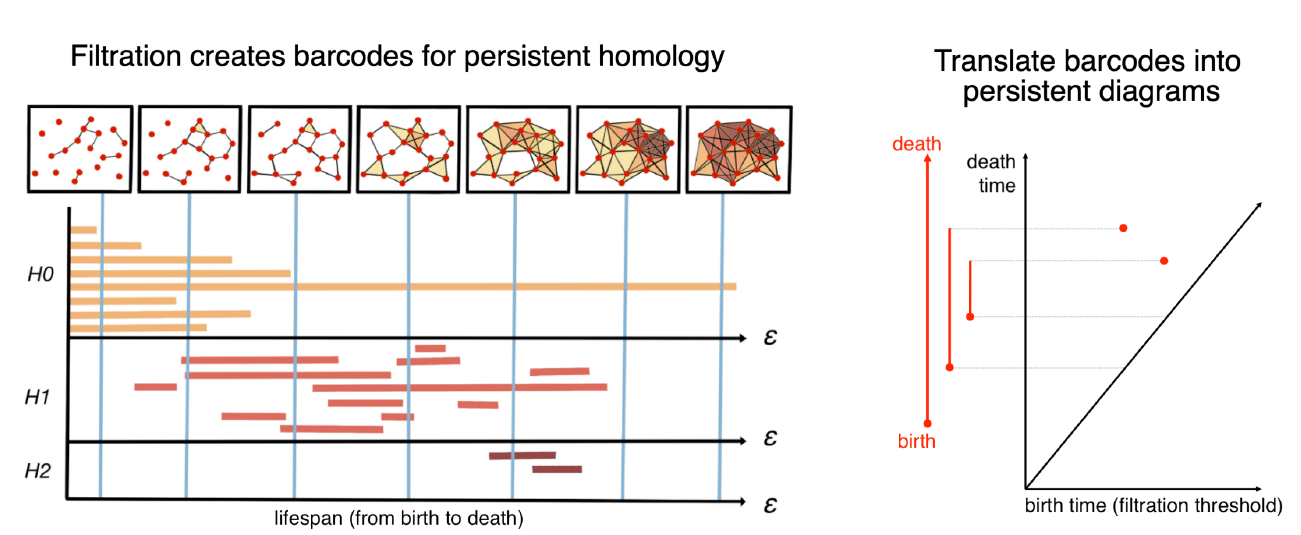
Figure 3. Persistent homology via mathematical filtration. In this schematic diagram, a point cloud of 19 data points is presented in a low-dimensional embedding space. In the filtration process, a parameter (cid:101) is swept from zero to the maximum pairwise distance within the point cloud, indicating a distance threshold under which the two points can form an edge to become one connected component in the graph. For each value (cid:101) , we obtain a space S (cid:101) consisting of vertices, edges formed